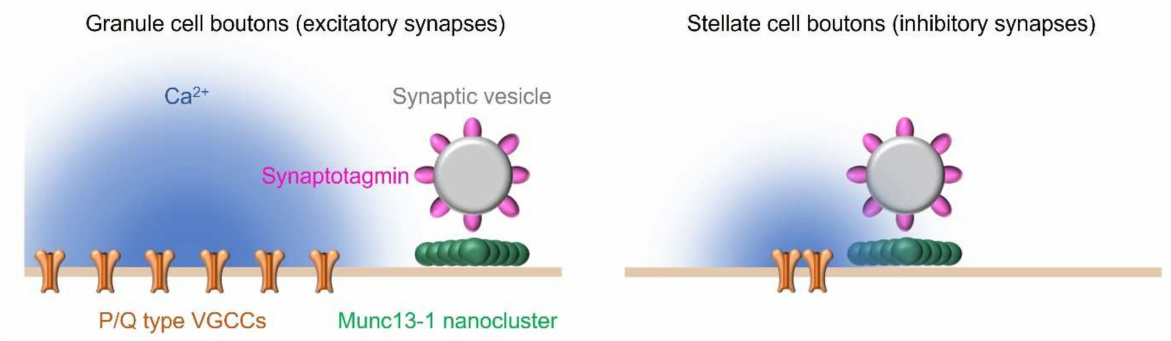
Figure 3. Differences in the distances between synaptic proteins allow synapse-specific regulation of the release probability at cerebellar synapses. Munc13-1 was located approximately 50 nanometers from P/Q-type VGCCs in granule cell boutons. In contrast, Munc13-1 was tightly coupled to a